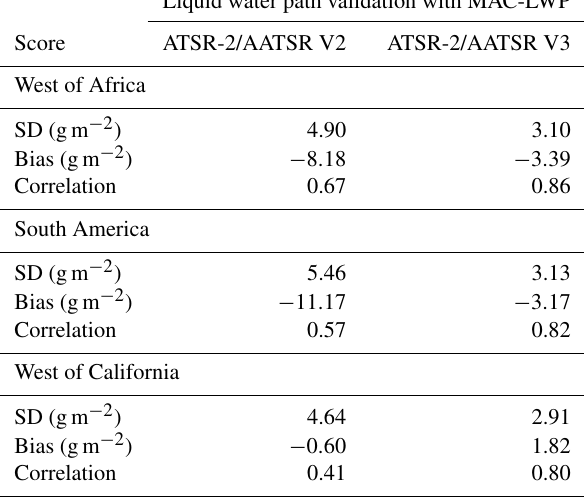
Table 5. Multi-annual (2000–2012) liquid water path valida- tion results for ATSR-2/AATSR when compared with MAC-LWP monthly data for three regions of predominantly stratocumulus cloud. The results for V2 (left) and V3 (right) are compared for correlation, bias and standard